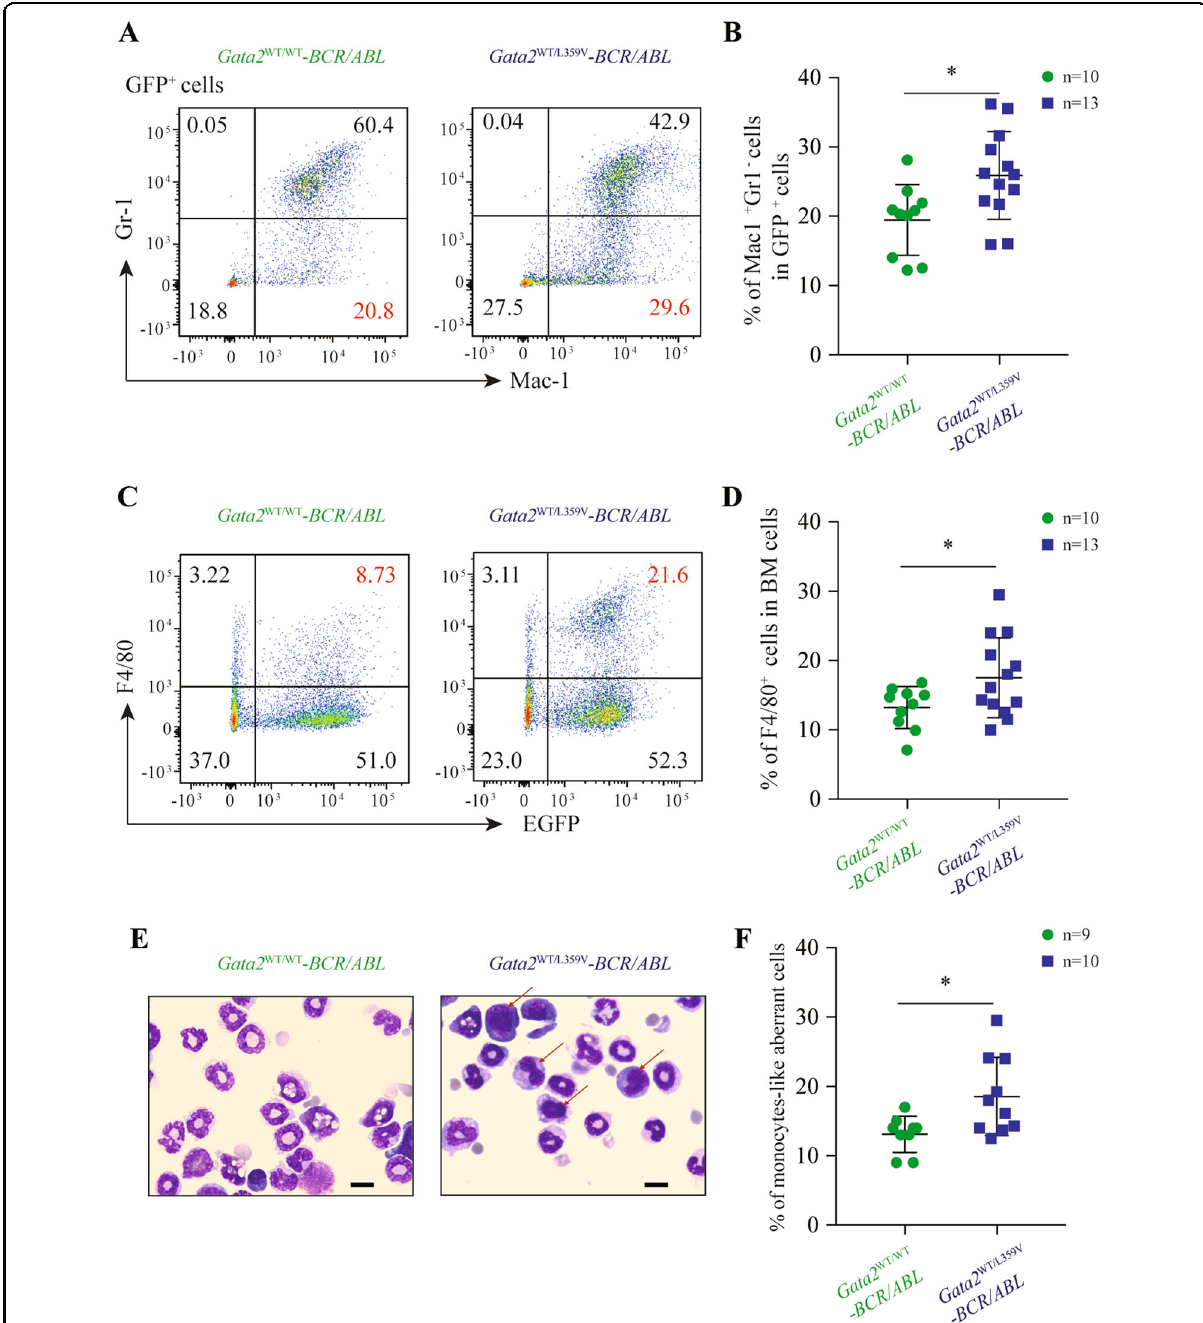
Fig. 6 Cell differentiation interference by Gata2 -L359V mutation in a murine model of chronic myeloid leukemia. A Representative display of fl ow cytometry analysis of Gr-1 − Mac-1 + cells in GFP + BM cells. B Statistical analysis of Gr-1 − Mac-1 + cell frequencies between Gata2 WT/WT - BCR/ABL ( n = 10) and Gata2 WT/L359V - BCR/ABL ( n = 13) mice. C Representative fl ow cytometry analysis of GFP + F4/80 + cells in total BM cells. D Statistical analysis of GFP + F4/80 + cell frequencies between Gata2 WT/WT - BCR/ABL ( n = 10) and Gata2 WT/L359V - BCR/ABL ( n = 13) mice. E Morphological analysis of BM cells in Gata2 WT/WT - BCR/ABL ( n = 10) and Gata2 WT/L359V - BCR/ABL ( n = 13) mice. BM cells were harvested and subject to Wright ’ s staining. The red arrows represent the atypical monocytes (scale bar 10 μ m). F Statistical analysis of the percentage of monocyte-like aberrant cells in BM between Gata2 WT/WT – BCR/ABL ( n = 9) and Gata2 WT/L359V - BCR/ABL ( n = 10) mice. Error bars represent the deviation from the average, and signi fi cant differences are indicated by * p <0.05 (Student ’ s t-